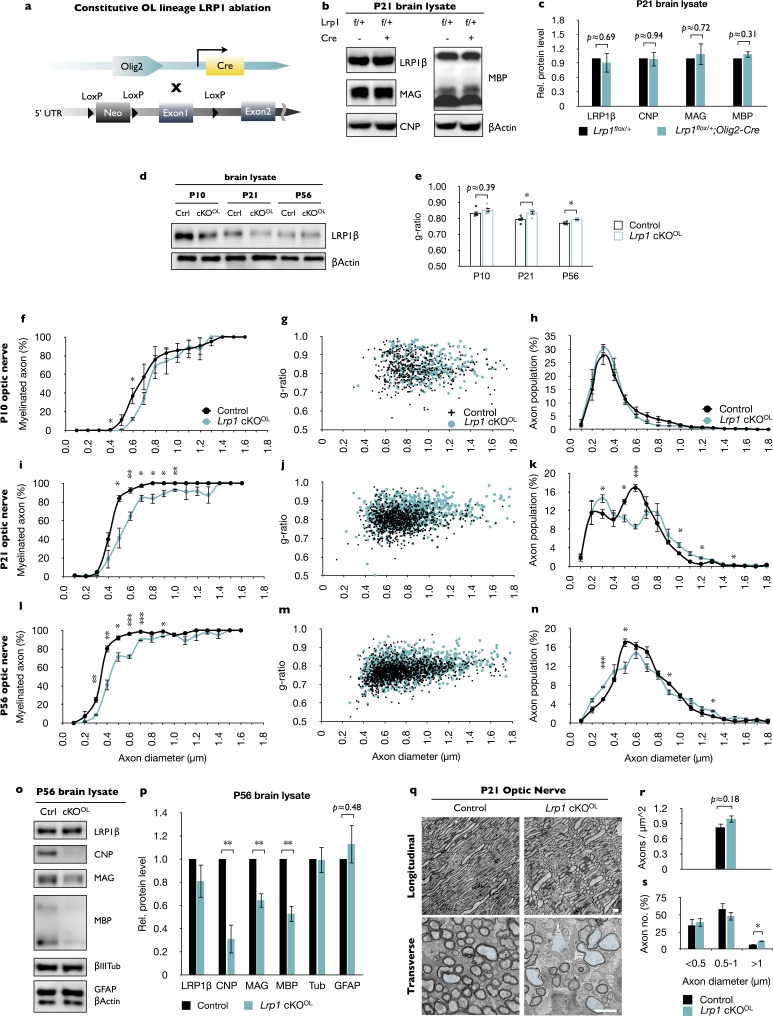
Lrp1 ablation in the OL lineage leads to CNS hypomyelination.(a) Lrp1flox/flox mice were crossed with Olig2-Cre mice to conditionally ablate Lrp1 in OL lineage (cKOOL). (b) To ensure that the presence of the Olig2-Cre allele does not lead to altered expression of myelin-associated proteins or LRP1, P21 brains of Lrp1flox/+ and Lrp1flox/+;Olig2-Cre mice were lysed and subjected to SDS-PAGE. Representative Western blots probed with anti-LRP1β, anti-MAG, anti-CNP, anti-MBP, and anti-β-actin are shown. (c) Quantification of protein levels detected by Western blotting of Lrp1flox/+ (n = 3) and Lrp1flox/+;Olig2-Cre (n = 3) brain lysates revealed no differences in the presence or absence of the Olig2-Cre allele. (d) Immunoblotting of whole brain lysates prepared from P10, P21, and P56 of Lrp1 control (Ctrl) and cKOOL mice. Representative blots probed with anti-LRP1β and anti-β-Actin. (e) Average g-ratio of myelinated optic nerve axons of Lrp1 control and cKOOL mice, n = 4 mice per genotype for each of the three time points. (f, i, and l) Graphs show the percentage of myelinated axons in the optic nerve at P10, P21 and P56 as a function of axon caliber in Lrp1 control (n = 4 for each time point) and cKOOL (n = 4 for each time point) mice. Axon calibers were binned into nine groups of 0.2 μm intervals, ranging from 0.1 to 1.7 μm. (g, j, and m) Scatter plot showing the distribution of g ratios for individual fibers in the optic nerve at P10, P21, and P56 of Lrp1 control and cKOOL mice. P10, n = 488 axons from Lrp1 control mice and n = 261 axons from cKOOL mice; P21, n = 1015 axons from Lrp1 control mice and n = 997 axons from 4 cKOOL mice; P56, n = 1481 axons from Lrp1 control mice and n = 1020 axons from 4 cKOOL mice. (h, k, and n) Morphometric assessment of axon caliber distribution in P10, P21, and P56 optic nerves of Lrp1 control (n = 4) and cKOOL (n = 4) mice. Measurements of axon diameter were made from electron microscopy images. (o) Immunoblotting of whole brain lysates prepared from P56 Lrp1 control (Ctrl) and cKOOL mice. Representative blots probed with anti-LRP1β, anti-CNP, anti-MAG, anti-MBP, anti-β-III tubulin, anti-GFAP, and anti-β-actin. (p) Quantification of protein levels detected by Western blotting of Lrp1 control (n = 3) and cKOOL (n = 3) brain lysates. (q) Electron microscopy images of optic nerve cross- and longitudinal-sections acquired from P21 Lrp1 control and cKOOL mice. Axons that are >1 μm in diameter are colored in light blue. Scale bar = 1 μm. (r) Quantification of axon density in the P21 optic nerve for Lrp1 control (n = 4) and cKOOL (n = 4) mice. (s) Quantification of optic nerve axons smaller than <0.5 µm, between 0.5–1.0 µm and larger than 1 µm in Lrp1 control (n = 4) and cKOOL (n = 4) mice. Results are presented as the mean ±SEM, *p<0.05, **p<0.01, and ***p<0.001, Student’s t-test. For a detailed statistical report, see Figure 2—source data 1.